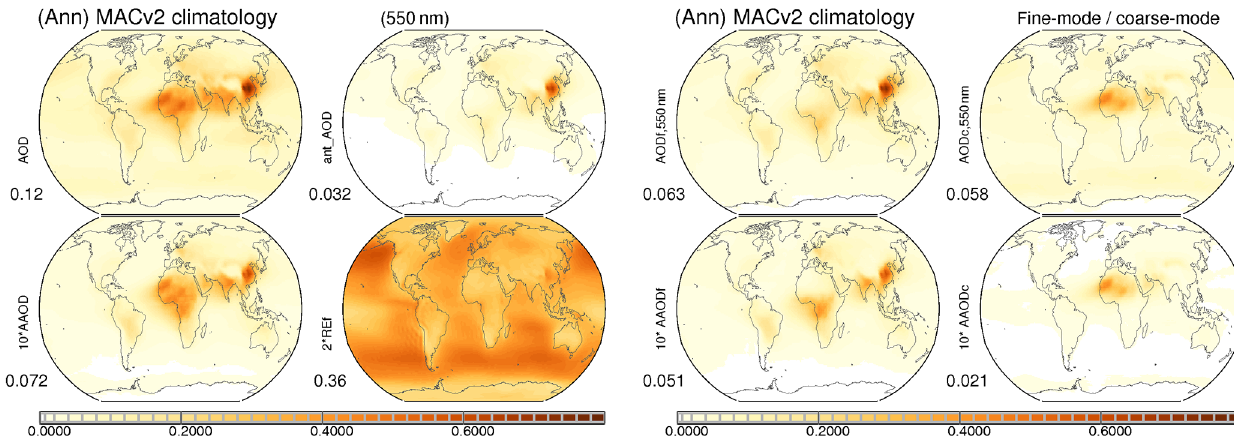
Figure 1. Annual average maps of the MACv2 aerosol climatology. Global distributions are presented for present-day column properties of aerosol amount (AOD), absorption (AAOD × 10), anthropogenic AOD and fine-mode effective radius (REf × 2) in micrometers (µm). Also presented are the midvisible AOD and AAOD split into fine-mode (radii < 0 . 5µm) and coarse-mode (radii > 0 . 5µm) contributions. Labels indicate global